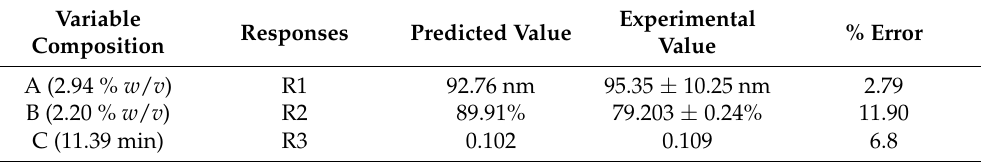
Table 5. The optimized composition using experimental design for the development of Dox–Erlo NPs with experimental and predicted